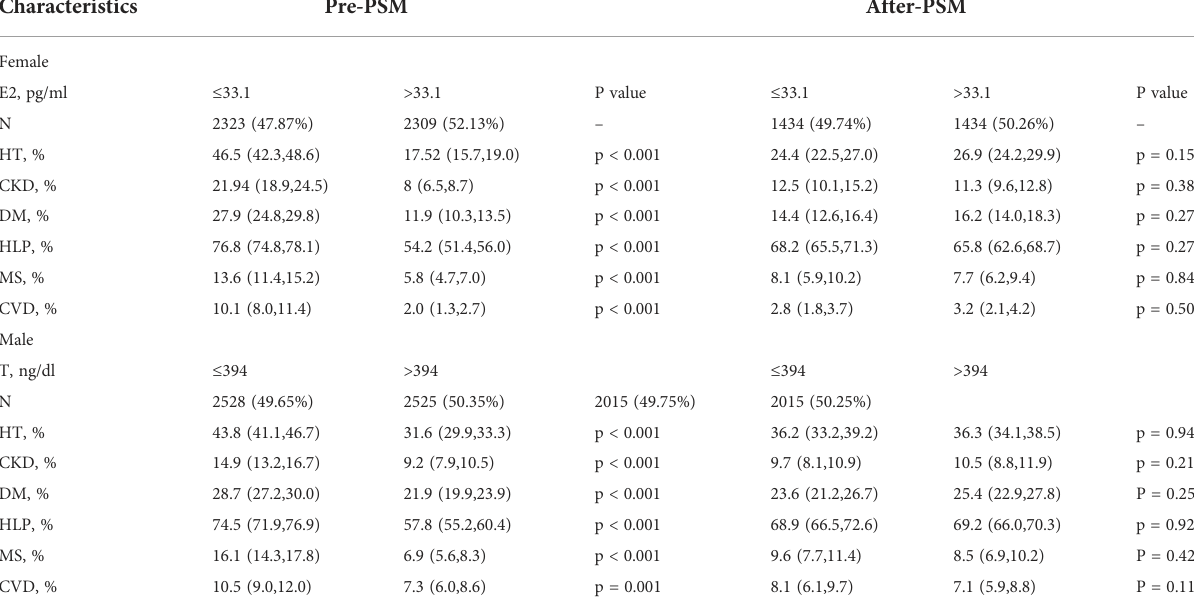
TABLE 3 |Baseline comparison of in fl uencing factors before and after PSM. Characteristics Pre-PSM